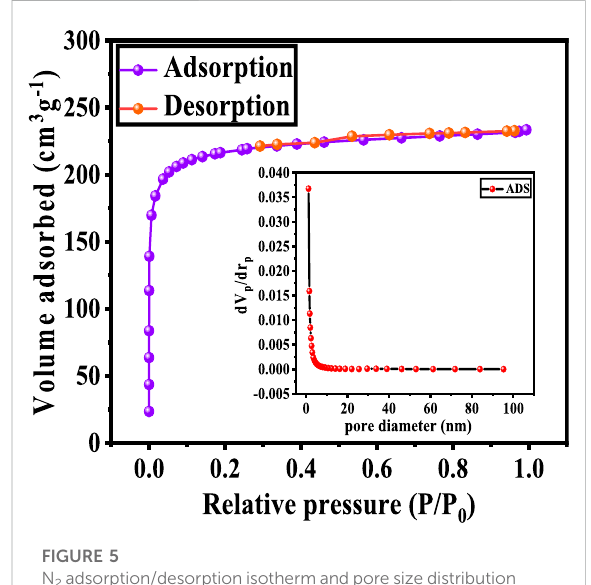
FIGURE 5 N 2 adsorption/desorption isotherm and poresize distribution of activated